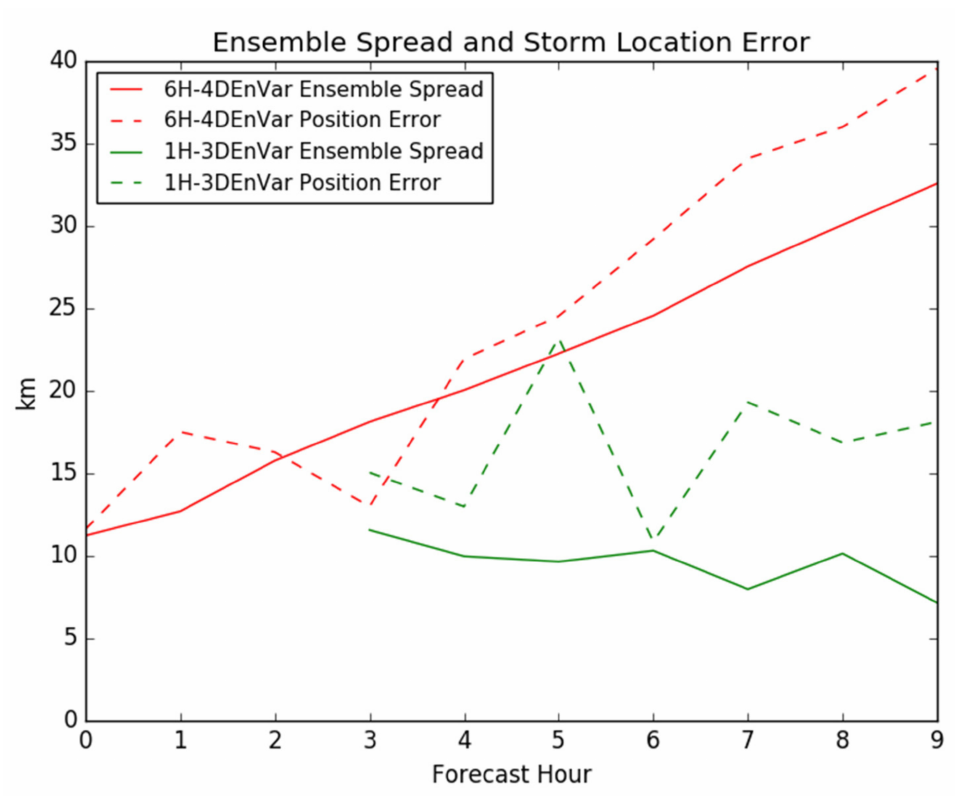
Figure 14. Ensemble spread (solid lines) and mean background position error (dotted lines) for 6H-4DEnVar (red) and 1H-3DEnVar (green) by forecast hour.